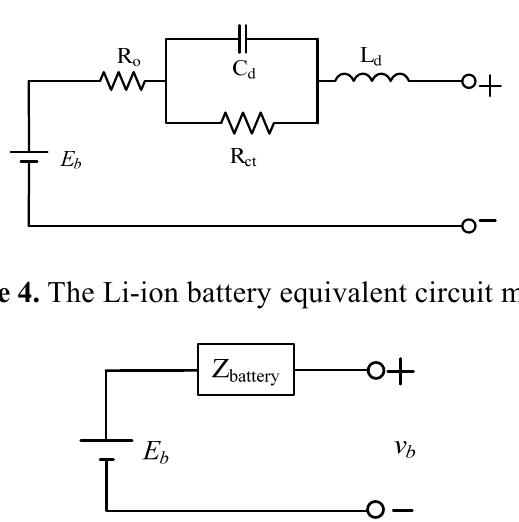
Figure 3. The simplified Li-ion battery AC impedance model.